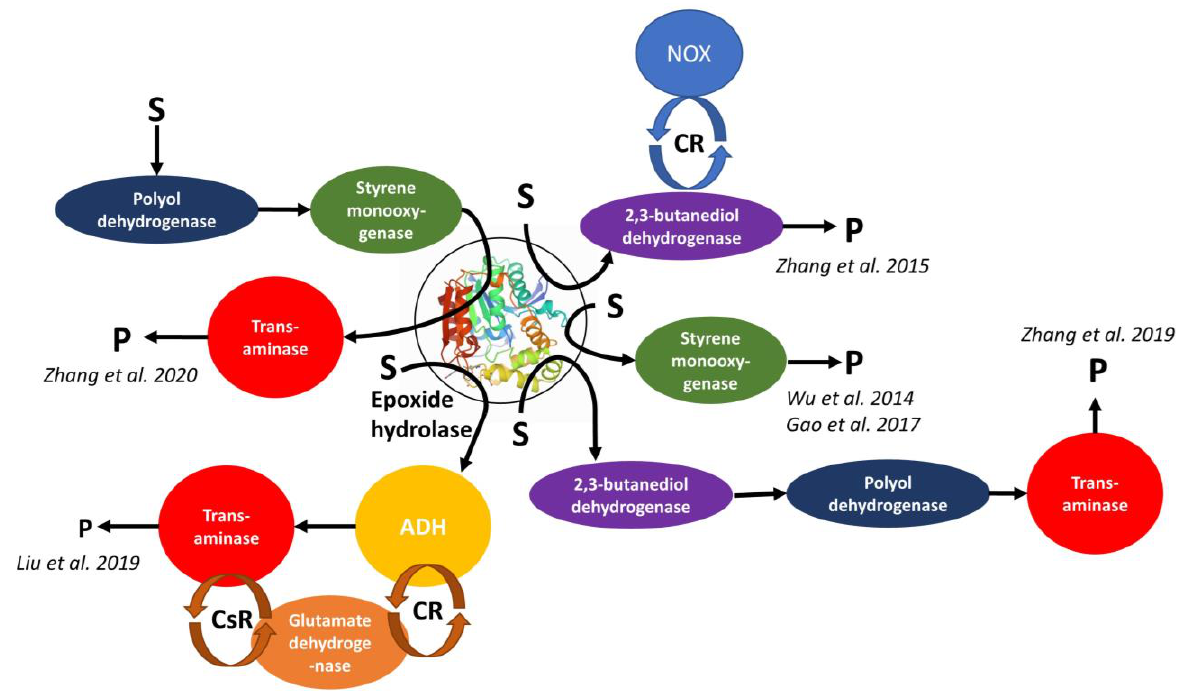
Figure 3. The importance and schematic incorporation of epoxide hydrolase SpEH from Sphingo- monas sp. HXN-200 into five independent, non-natural enzyme cascades consisting of two, three, and four enzymes, co-expressed and used in the form of five whole-cell systems, as mentioned in Table 4; S: substrate, P: product, CR: cofactor regeneration, CsR: co-substrate regeneration, NOX: NADH oxidase, and ADH: alcohol dehydrogenase